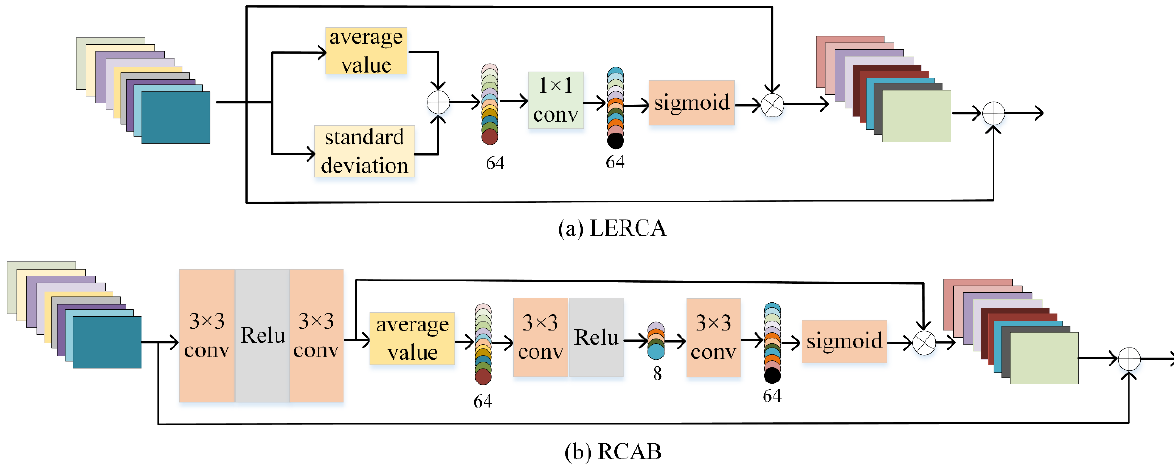
Figure 3. ( a ) Lightweight enhanced residual channel attention ( b ) residual channel attention block (8 and 64 in the figure represent different number of channels, respectively.)